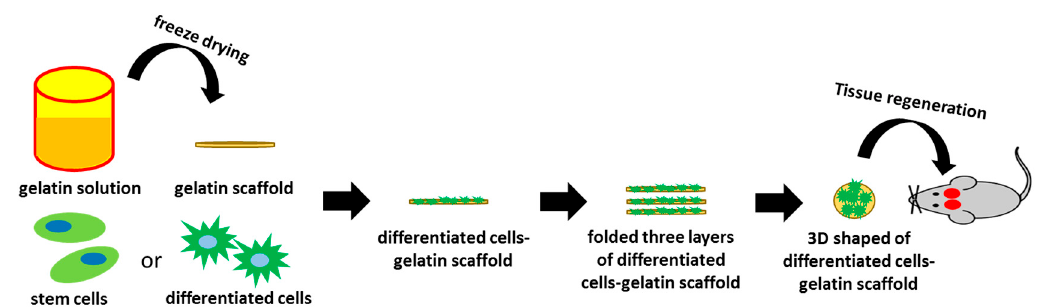
Figure 9. Schematic representation of the implantation of the functionalized gelatin scaffold for bone tissue regeneration in rats.